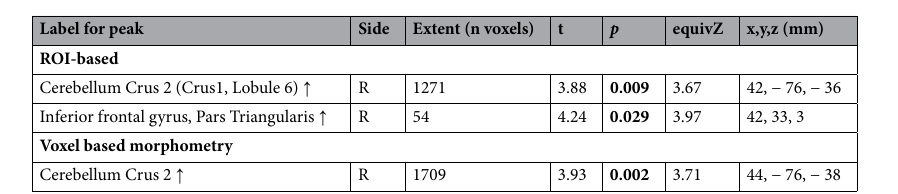
Table 3. Regional gray matter volumes (ROI-based and voxel based morphometry analyses) and fantasy IRI subscale. Results are FWE corrected. Coordinates are in Montreal Neurological Institute (MNI) space. L left, R right. p = significance (FWE corrected) at the cluster level (Cerebellum Crus 2) and at the peak level (Inferior Frontal Gyrus, Pars Triangularis). Significant results (p < 0.05) are in Bold.